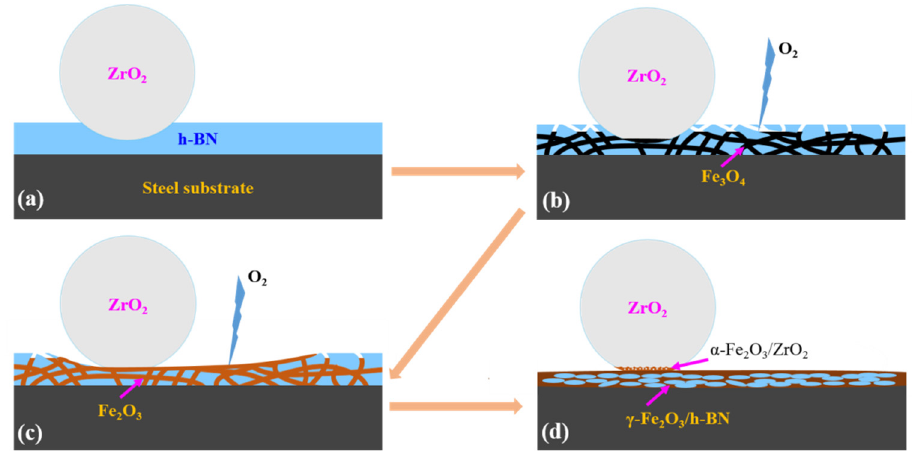
Figure 14. Schematic diagram of the friction process at 800 °C: ( a ) at initial stage, ( b ) the oxidation stage, ( c ) the phase change stage and ( d ) superlubricity stage.